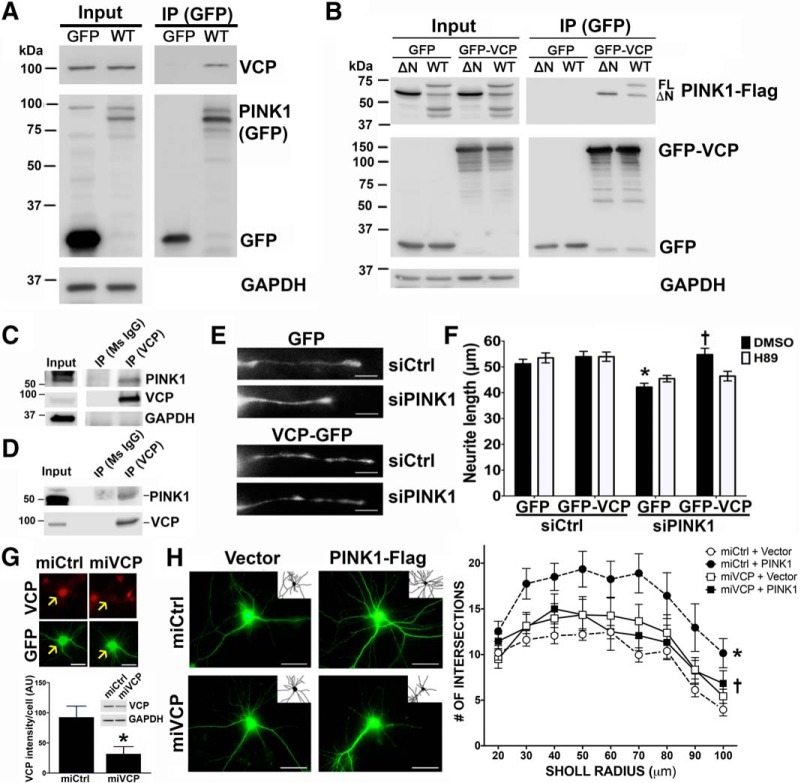

VCP interacts with PINK1 and is required for PINK1-mediated dendritogenesis. A, Immunoblot of GFP IP products of HEK293 cells expressing GFP or WT-PINK1-GFP show that PINK1-GFP pulls down endogenous VCP (representative of five independent experiments). B, GFP IP products of HEK293 cells co-expressing GFP or GFP-VCP and ΔN-PINK1-FLAG or WT-PINK1-FLAG show that GFP-VCP pulls down both full-length and processed PINK1 (representative of three independent experiments). C, IP of endogenous VCP probed for endogenous PINK1 from HEK293 cells. D, IP of endogenous VCP probed for endogenous PINK1 from human brain cortex. E, F, SH-SY5Y cells were co-transfected with scrambled control (siCtrl) or PINK1 siRNA (siPINK1) and with either GFP or GFP-VCP. Representative images of neurites are shown (E, scale bars = 10 μm), oriented with the somatic-neuritic junction to the left. F, Quantification reveals that GFP-VCP rescues neurite shortening induced by siPINK1 (mean ± SEM; four independent experiments, 196–222 cells/group; *p < 0.0001, siPINK1 + GFP vs siCtrl + GFP; †p < 0.0001, siPINK1 + GFP-VCP vs siPINK1 + GFP. In SH-SY5Y cells, siPINK1 reduced expression of PINK1 mRNA to 49 ± 2.5% of siCtrl by Q-RT-PCR (N = 4). G, VCP knock-down in mouse primary cortical neurons was verified by immunofluorescence for VCP (red). Arrows indicate transfected neurons (green; scale bars = 25 μm). Fluorescence intensity for VCP was quantified in neurons seven days after transfection with miCtrl versus miVCP (*p = 0.0006, representative of two independent experiments). Protein and mRNA knock-down were also confirmed in mouse neuronal HT22 cells 24 h after transfection, with mRNA reduced to 41.6 ± 2.2% of control cells by Q-RT-PCR (three independent experiments). Western blotting (inset) and band densitometry reveals that miVCP reduced VCP protein expression to 43.9–52.3% of miCtrl in two independent experiments. H, Representative images and dendrite tracings (insets) of cortical neurons (scale bars = 50 μm) transfected with Vector or PINK1-Flag and miCtrl or miVCP. Sholl analyses reveals that the ability of PINK1 to increase dendritic complexity is inhibited by knock-down of VCP (mean ± SEM; 10–13 neurons/group, three independent experiments; R
2 = 0.2138, F(3,44) = 3.9899; *p = 0.0015, miCtrl + PINK1 vs miCtrl + vector; †p = 0.0189, miVCP + PINK1 vs miCtrl + PINK1).